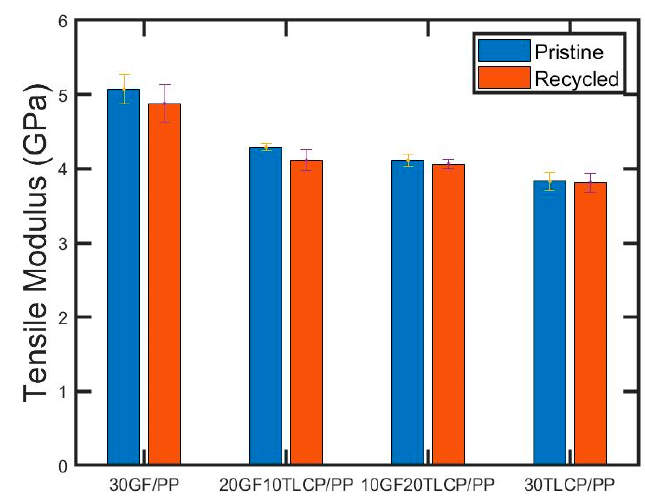
Figure 7. Tensile modulus of pristine and recycled hybrid composites in the flow direction.